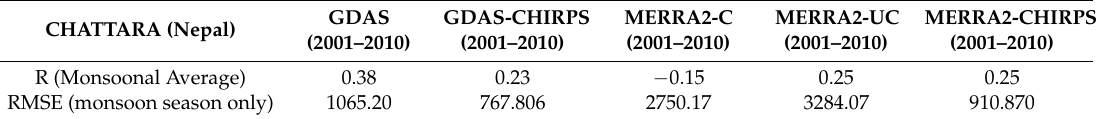
Table 5. The Pearson correlation coefficient and the root mean square error between the annual (monsoon season) model and the observed streamflow at Chattara (Nepal) (see Table 1 for details about